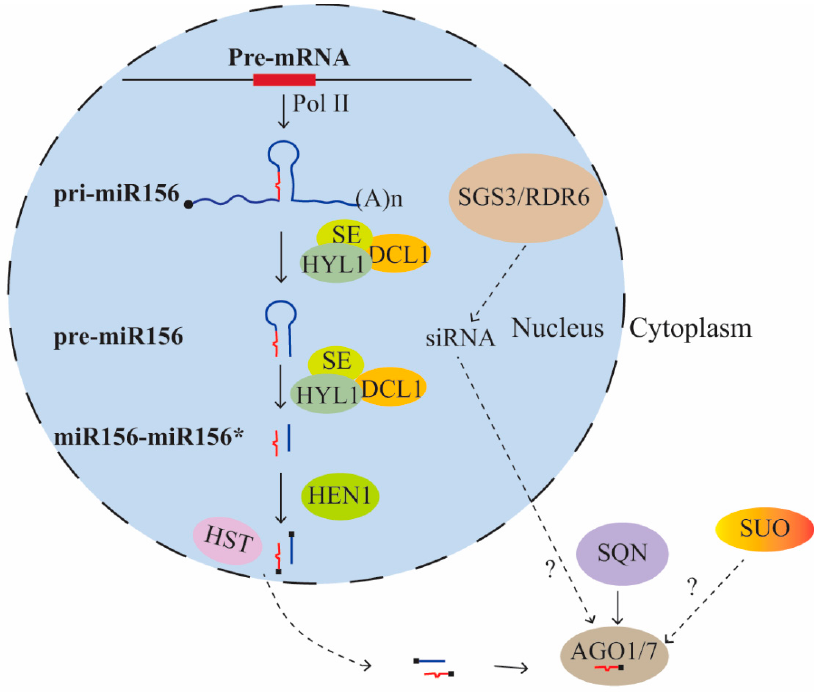
Figure 1. Biogenesis of miR156.